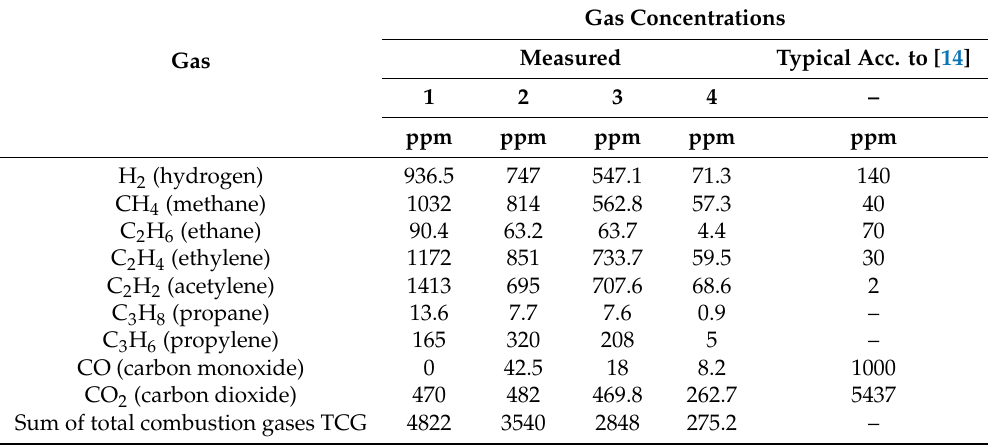
Table 10. Results of the measurements of gas concentrations in oil samples taken from the bushings after the lightning impulse tests (exceedance of the typical values is marked in bold font).